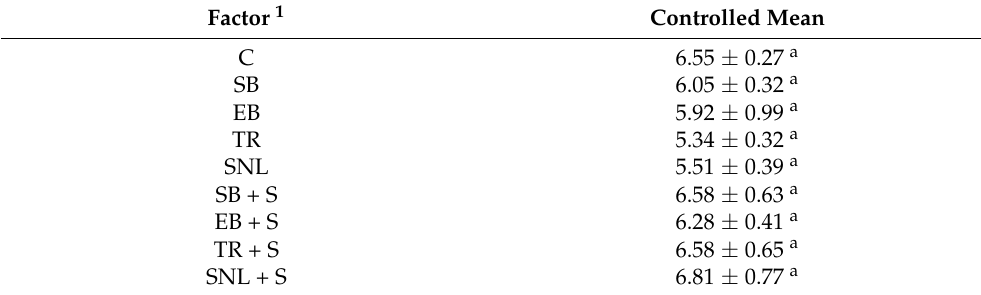
Table 4. Means and standard deviations for percent moisture loss of each treatment.